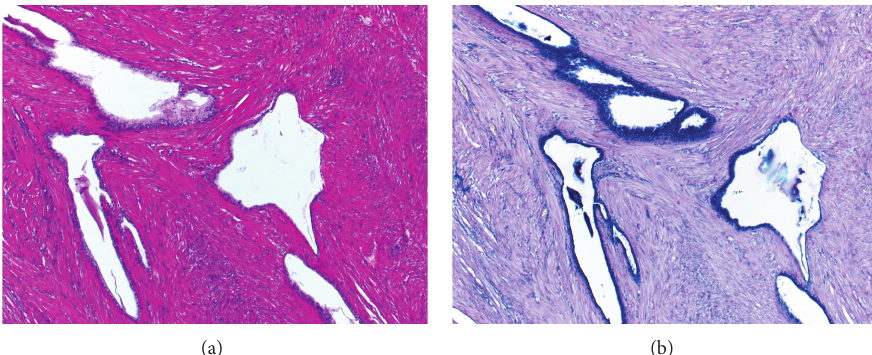
Figure 1: Histologic features of polypoid adenomyoma of endocervical type ((a) hematoxylin and eosin and (b) alcian blue-periodic acid- Schiff). The nodule is histologically composed of benign mucin-producing glandular cells and smooth muscle bundles. The cytoplasmic mucin is solely alcianophilic.